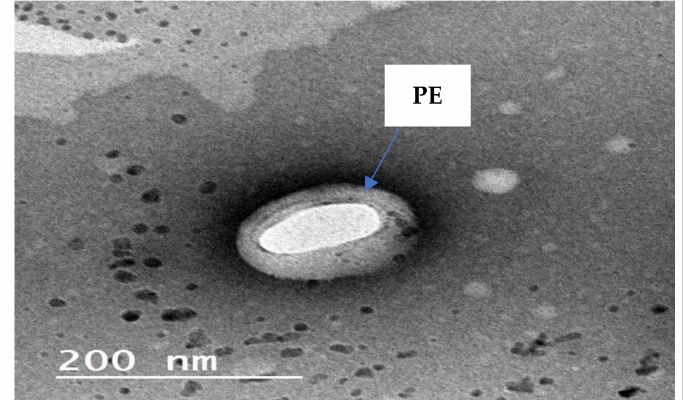
Figure 14. TEM of the elected optimized PEGylated bilosome (F7).